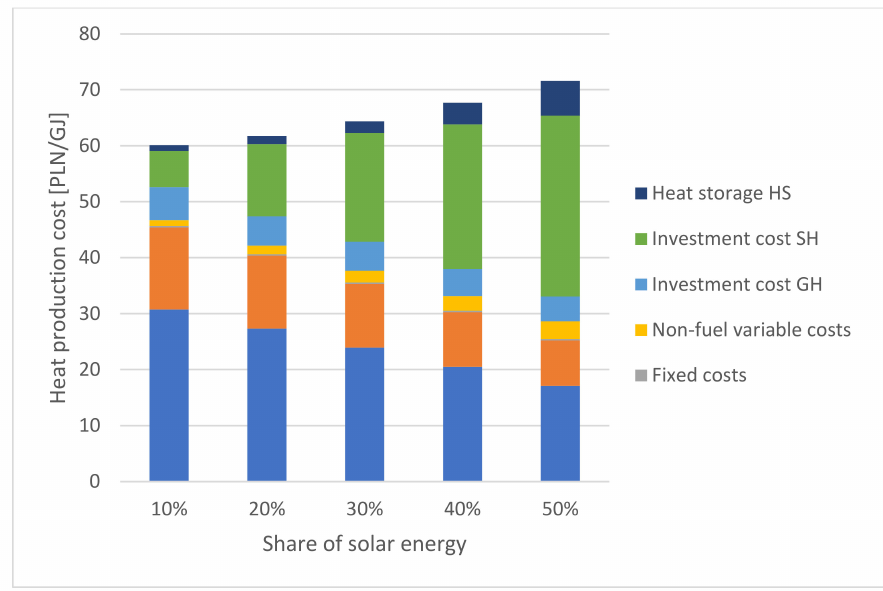
Figure 8. Distribution of heat generation cost components as a function of solar energy